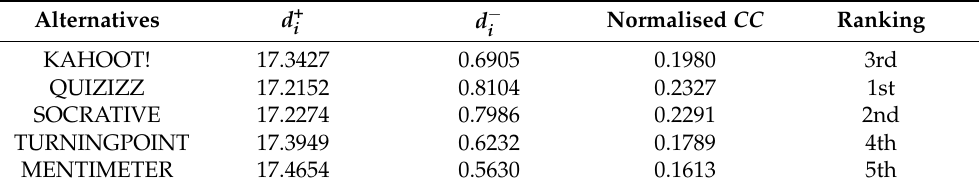
Table 11. The distances, normalised closeness coefficient, and ranking of alternatives in the case of W S = 0.5 and W O = 0.5, using objective weights from exponential entropy.